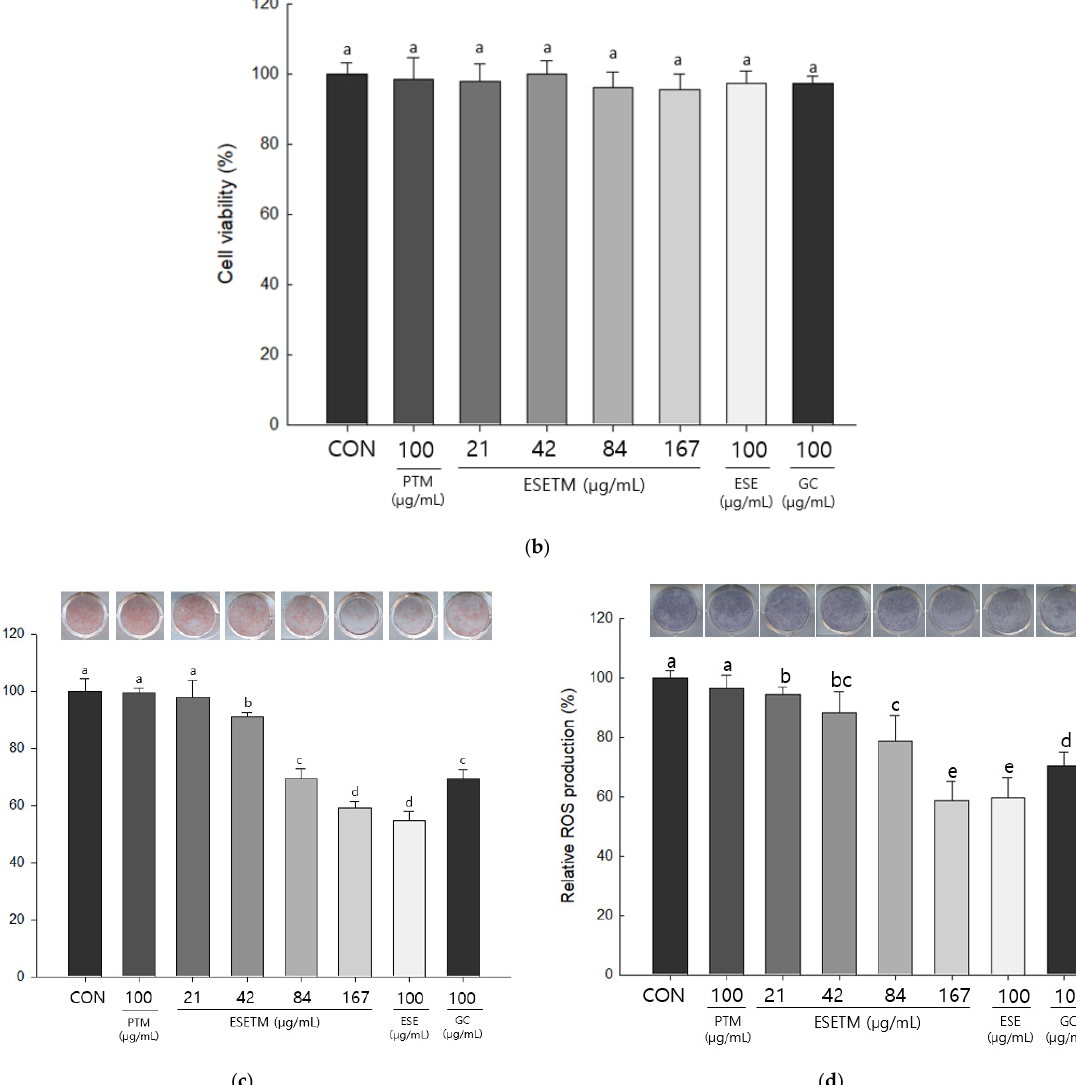
Figure 3. Effects of ESETM supplementation for 7 weeks on adipocyte size ( a ) in ICR mice fed high-fat diet (HFD). Cell viability ( b ), lipid accumulation ( c ) and relative ROS production ( d ) from 3T3-L1 adipocytes treated with ESETM. Data are shown as the means ± standard deviation (SD) ( n = 5). Different lower case letters above columns indicate statistical differences at p < 0.05.